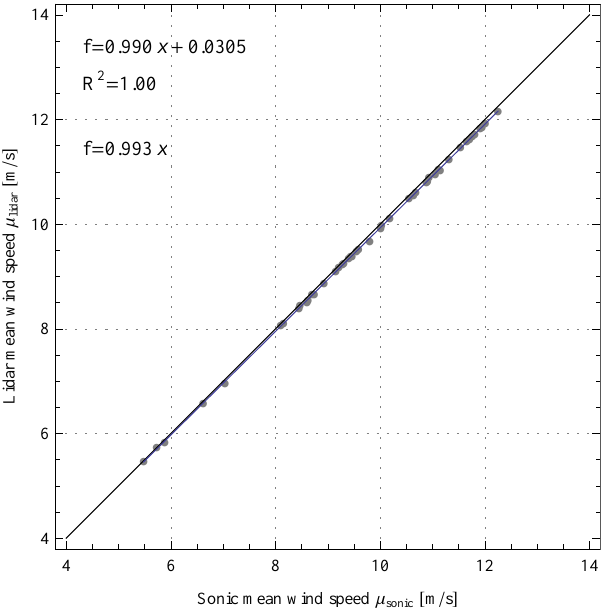
Fig. 2. Comparison of half-hour averages of the LOS velocity from the lidar and the corresponding velocity component of the sonic. Expressions for a linear fit with and without an offset are shown. Data are obtained during the day of 5 May